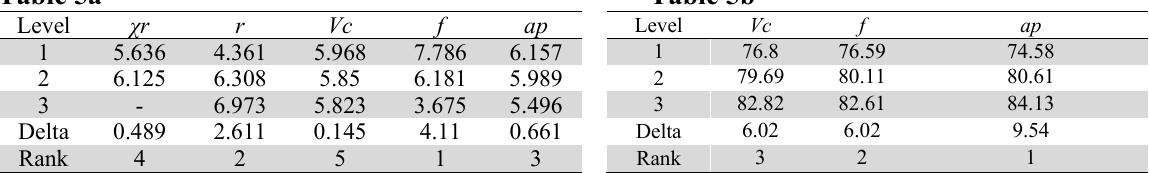
S/N response table for: (a) surface roughness (Smaller is better), (b) material removal rate (Larger is